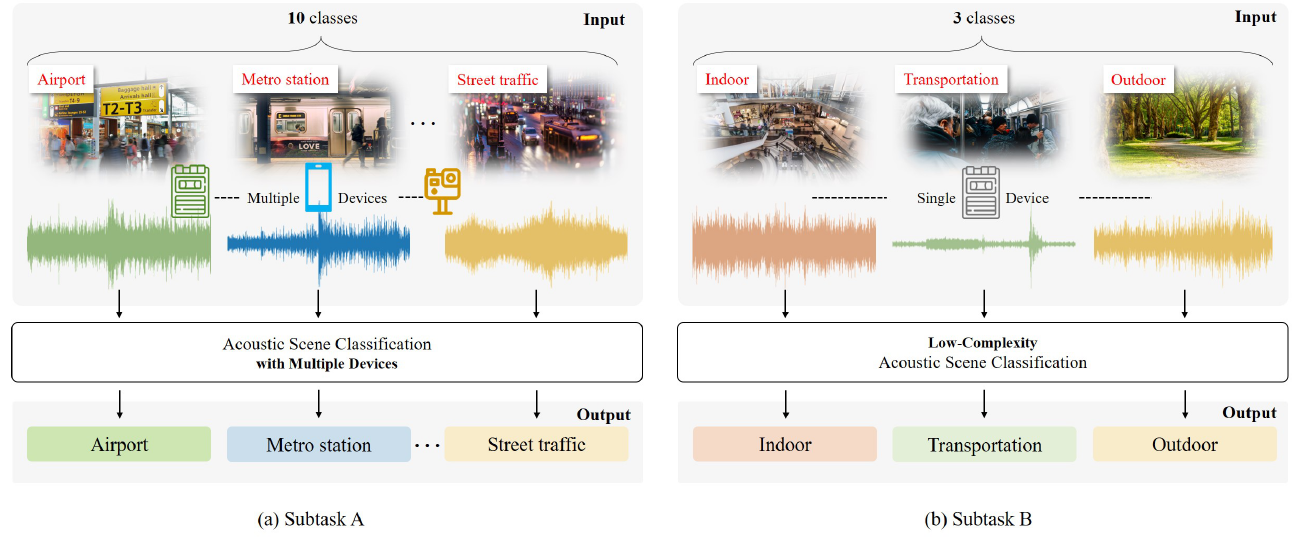
Figure 1. Overview of the ASC system for ( a ) subtask A and ( b ) subtask